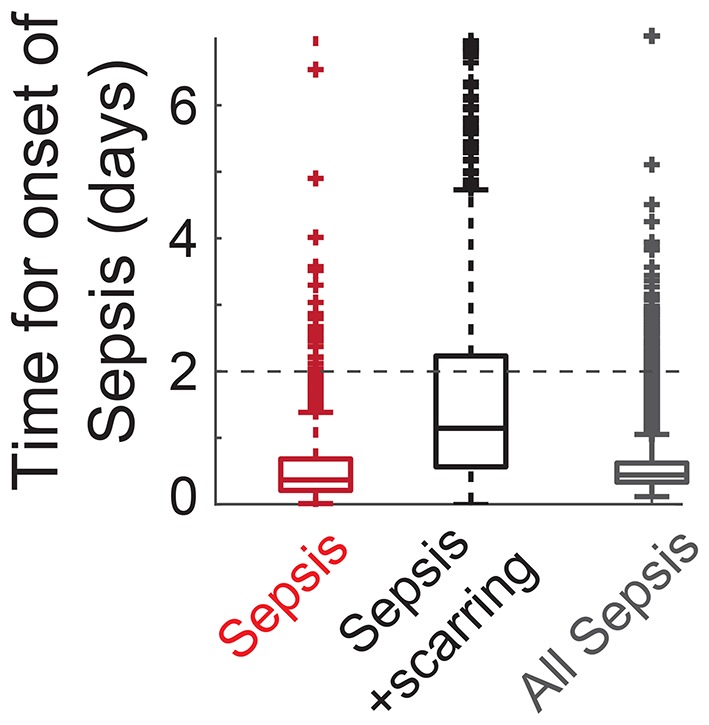
Computationally predicted time for onset of sepsis.